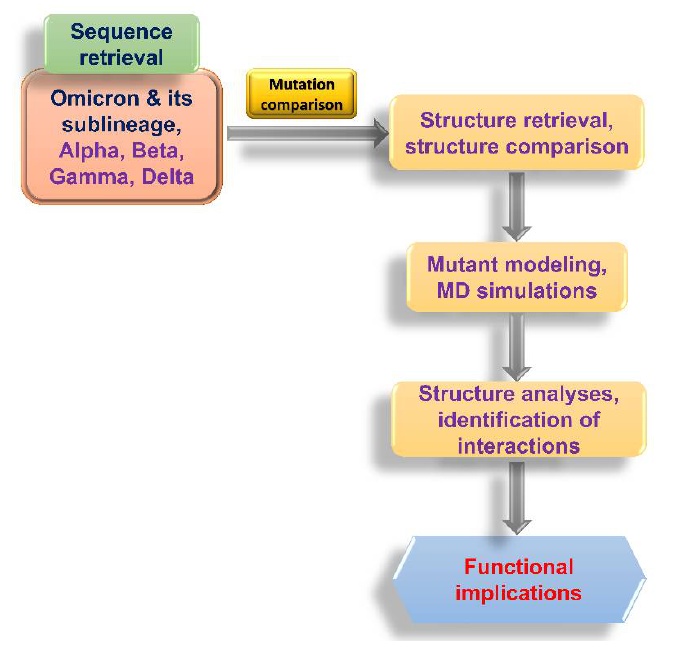
Figure 1. Flowchart of the analyses conducted in this study.